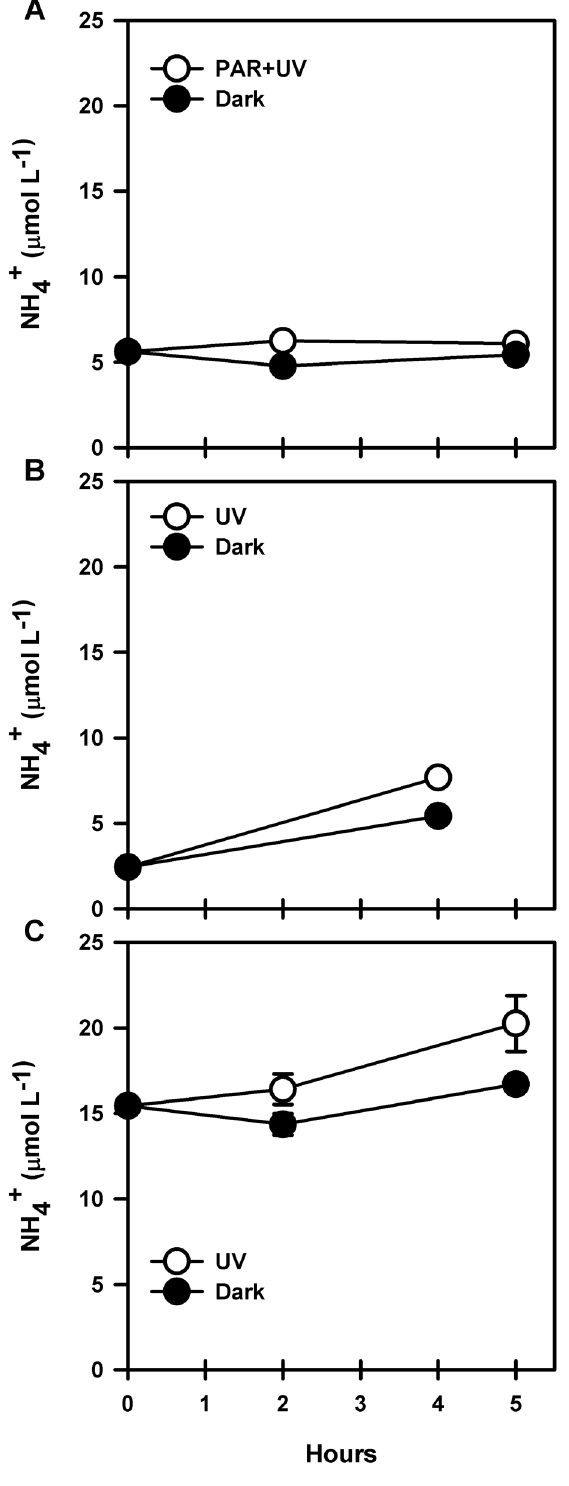
Figure 4. Evolution of ammonium concentrations during experiments of dissolved organic matter photodegradation using exudates of cultured T. minuscule at different cell densities. A) 2.82E + 06, B) 3.41E + 06, C) 3.65E + 06 cell mL 2 1 . Error bars show standard deviation for duplicate samples.